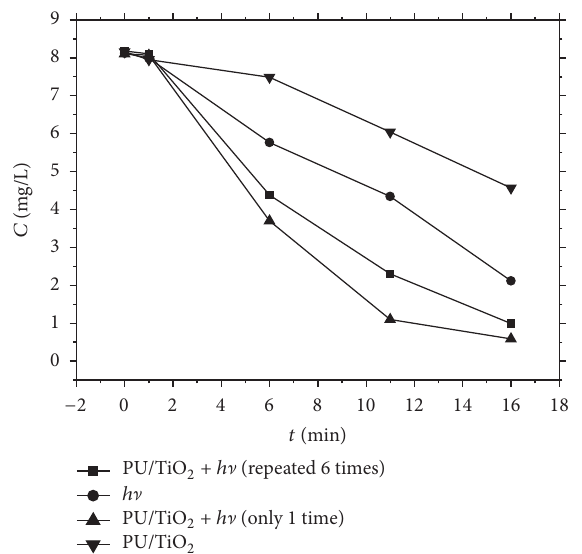
Figure 9: Degradation of methyl orange in different